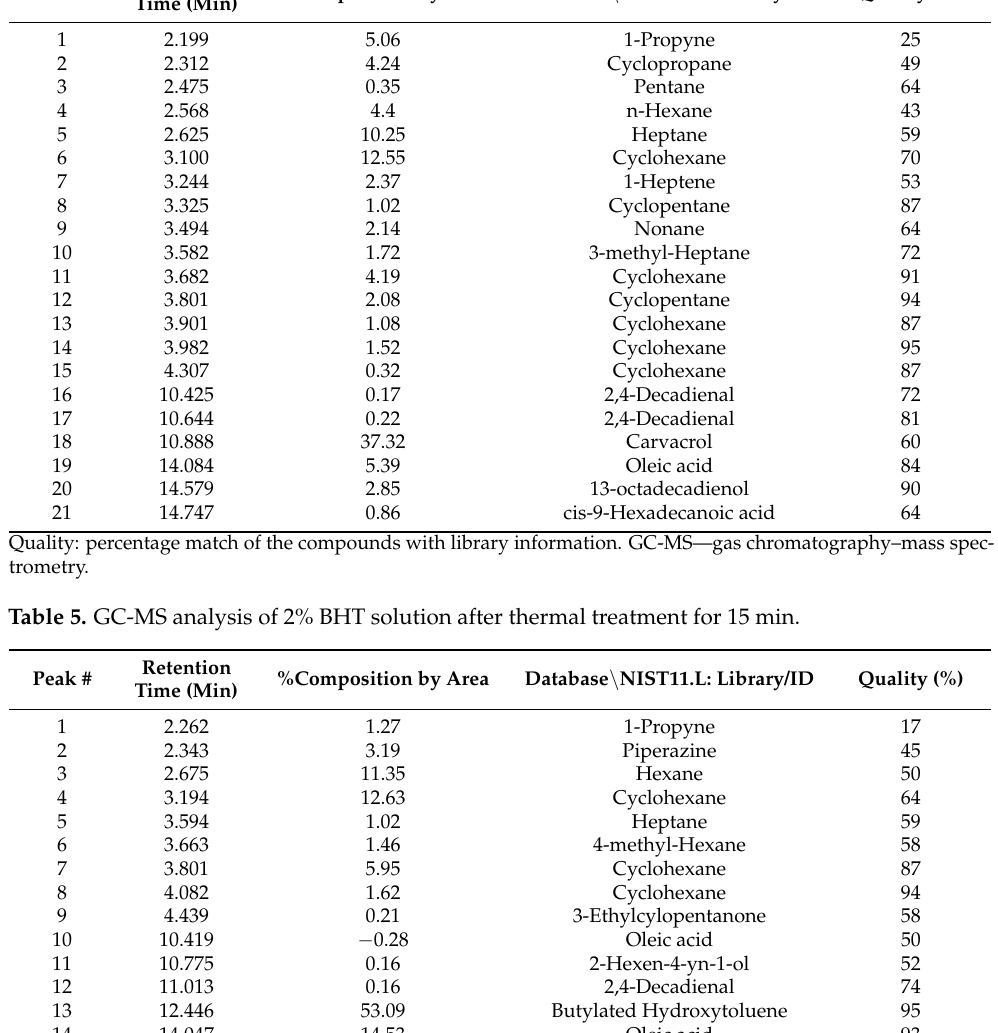
Table 5. GC-MS analysis of 2% BHT solution after thermal treatment for 15 min.